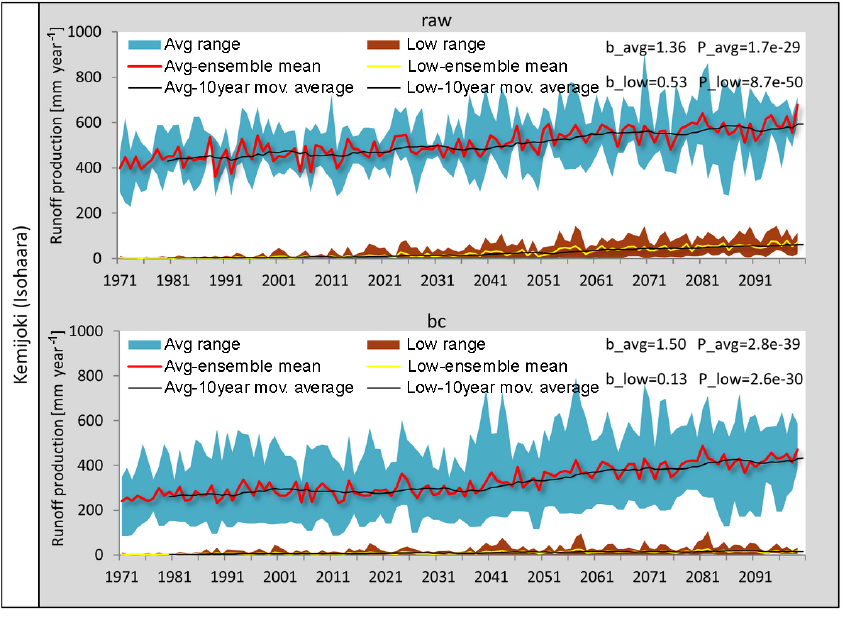
Figure 6. Annual time series of basin averaged runoff production (average and 10th percentile of annual runoff) for raw and bias adjusted Euro-CORDEX data. For both average and 10th percentile time series, the ensemble range, mean and 10-year moving average is